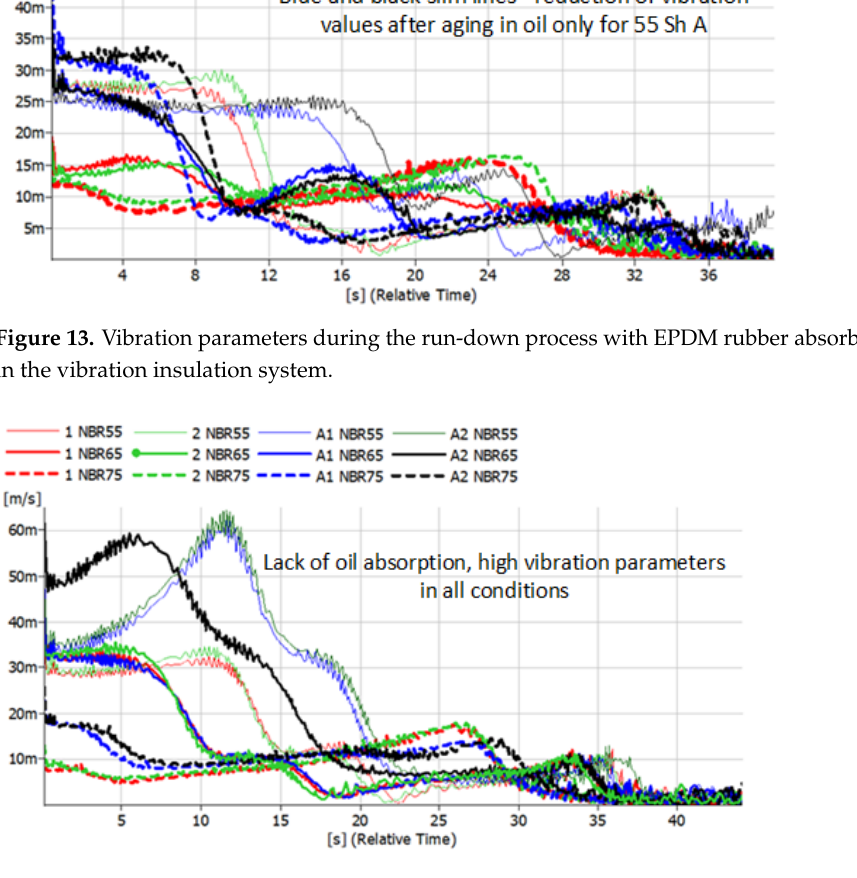
Figure 15. Vibration parameters during the run-down process with PU absorbers installed in the vibration insulation system. The convention of marking the individual waveforms of velocities of vibrations dur- ing the run-down process adopted in the figures is as follows: red — waveforms recorded for new shock absorbers; green — waveform recorded during the run-down of the machine after 500,000 revolutions; blue — new shock absorbers subjected to the action of petroleum products for 48 h; black — shock absorbers subjected to oil for 48 h and 500,000 forces. The continuous slim line indicates the materials with a hardness of 55 ShA. The continuous light line indicates the waveforms of vibration acceleration specific to the materials with a hardness of 65 ShA. The dashed line indicates the hardness of 75 ShA. Before and after the shock absorbers were subjected to the effects of petroleum products, they were meas- ured and weighed. The results are shown in Table 1. The tested rotor machine is a supercritical device, which means that it goes through at least one resonant speed during start-up and stop. In Figures 12 – 15, the passage through three renaissance velocities is clearly visible. This is manifested by a sharp in- crease in amplitude with a decrease in rotational speed (in our case, with the passage of time during the run-down process). The results of the CR rubber obtained at this stage of the research indicate that for all the hardness of this type of rubber, the influence of petro- leum products on its vibration damping properties is visible. The possibilities of energy dissipation increased significantly because this type of rubber absorbed the most petro- leum products, which can be seen in Table 1. The geometrical dimensions of the shock absorbers made of CR rubber have also changed. Despite improvements of the damping